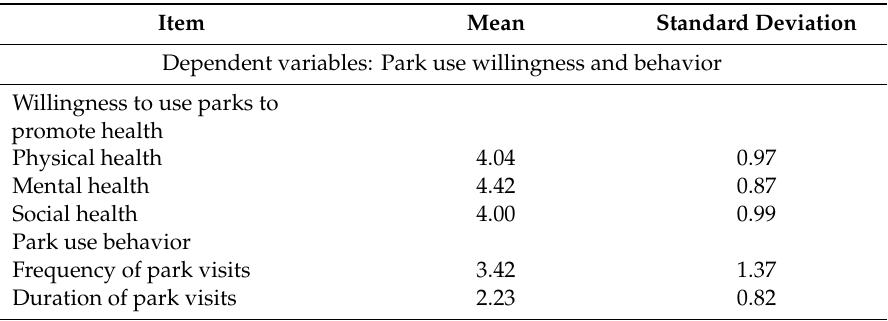
Table 3. Descriptive statistics for the dependent and independent variables (N =